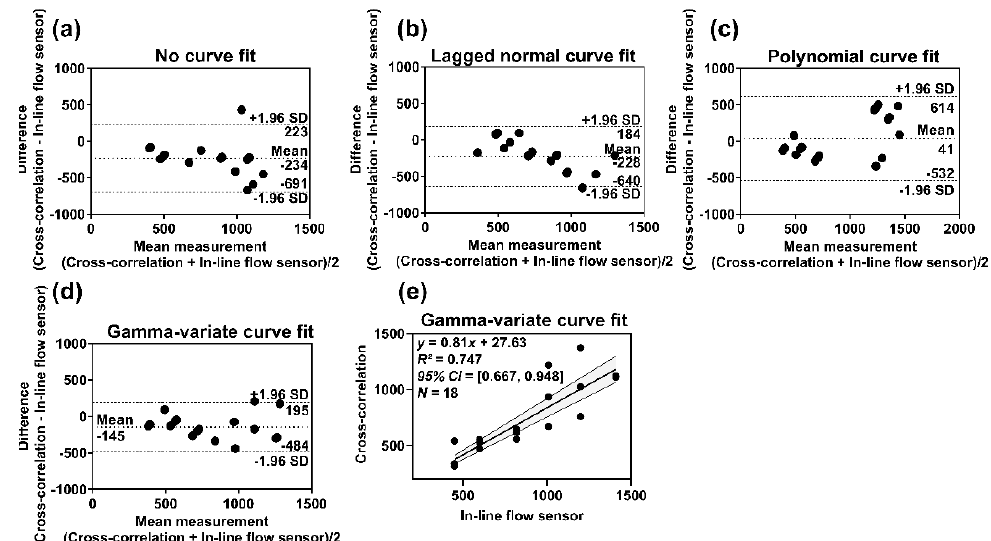
Figure 6. ( a – d ) Bland–Altman plots for DSA acquisition showing the bias (mean) and limits of agreement (mean ± 1.96 × SD) for CC algorithm with/without curve fitting versus in-line flow sensor measurement, ( e ) Scatter plot showing the correlation between measurements of CC algorithm with gamma-variate curve fit versus in-line flow sensor reading, along with 95% confidence bands of the best-fit line. (For fluoroscopic imaging, refer to Figure S3).